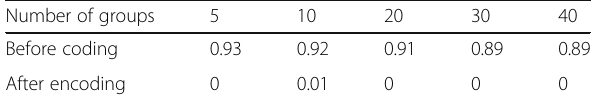
Table 2 FAR and FRR for different